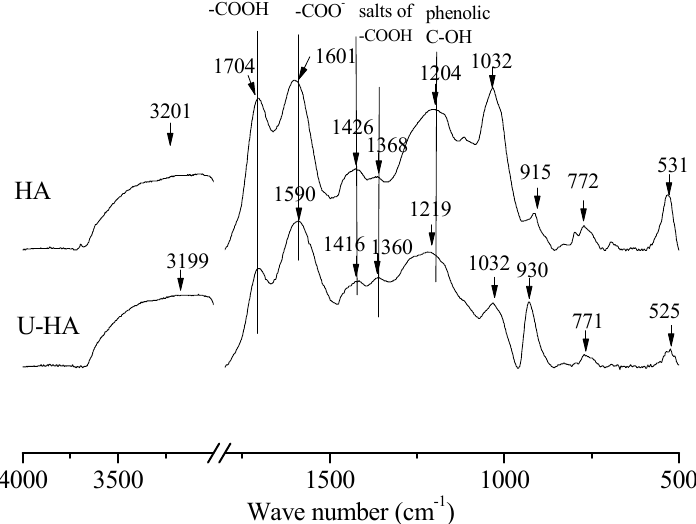
Figure 1. The FTIR spectra of humic acid (HA) before and after reaction with U(VI).